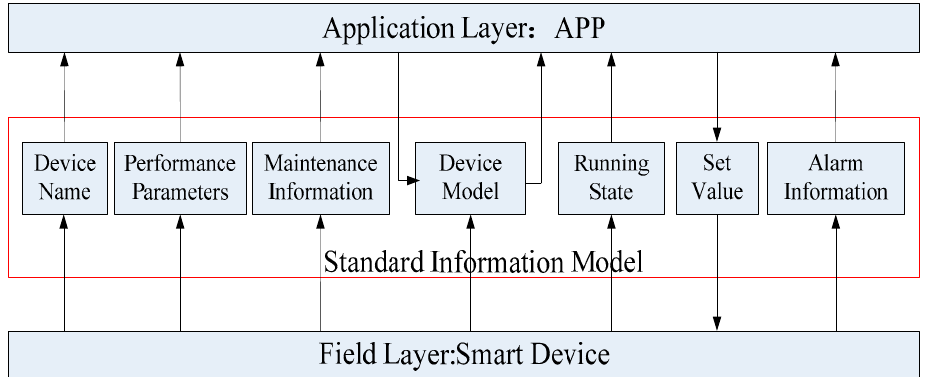
Figure 3. The application of standard information model.